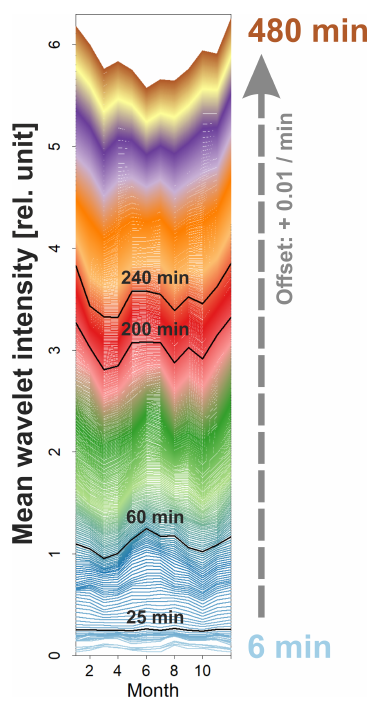
Figure 3. Monthly-mean values of nocturnal means of significant wavelet intensity (averaged over all years at OPN). The cycles are separated by gravity wave period and are coloured and provided with an offset of 0.01min − 1 of wave period to make the gradual transition of annual behaviour with growing wave periods